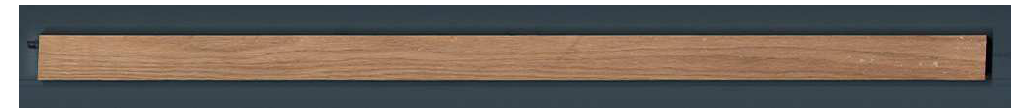
Figure 2. An image of a wooden board.